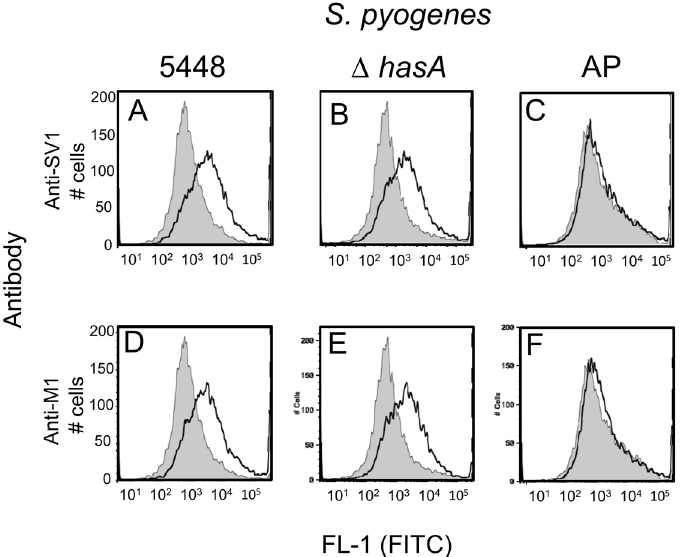
Fig 6. Overexpression of capsule reduces antibody binding to the surface of GAS. Representative histograms showing the binding of anti-SV1 antibodies to (A) the invasive M1 GAS strain 5448, (B) the acapsular Δ hasA and (C) the capsule overexpressing 5448 AP. Binding and anti-M1 antibodies to the same strains is shown in panels D-F respectively. In all images the grey shaded histogram represents binding of sera from mice immunised with PBS to GAS cells and open black lined histograms represent anti-SV1 or anti- M1-protein antibody binding to GAS